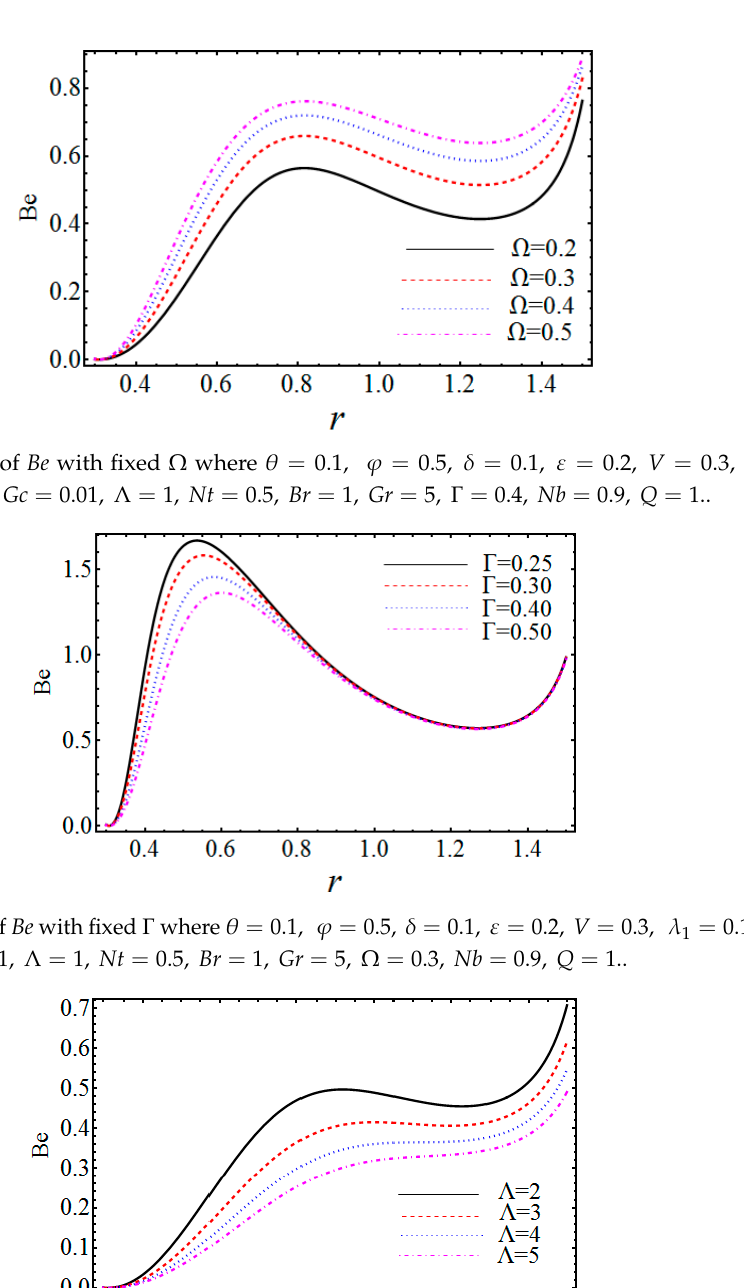
Figure 19. Curves of 𝐵𝑒 with fixed 𝐺𝑐 where 𝜃 = 0.1, 𝜑 = 0.5, 𝛿 = 0.1,𝜀 = 0.01,𝑉 = 0.3, 𝜆 (cid:2869) = 0.1, 𝑧 = 0, 𝑡 = 0.1, Ω = 0.3, Λ = 1, 𝑁𝑡 = 0.5, 𝐵𝑟 = 1, 𝐺𝑟 = 5, Γ = 0.4, 𝑁𝑏 = 0.9, 𝑄 = 1.